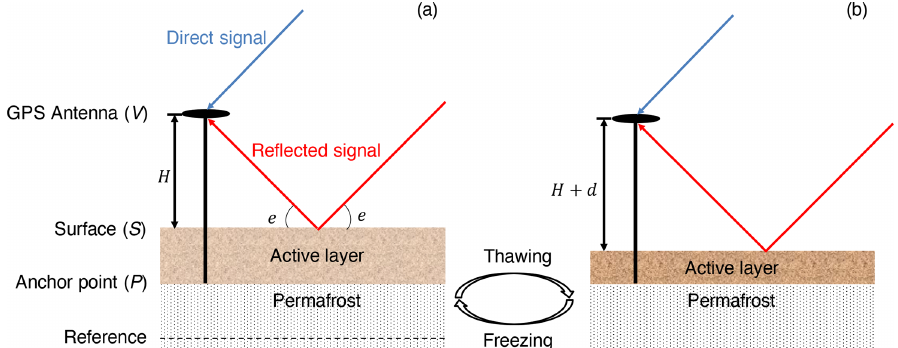
Figure 2. Diagrams showing the geometries of GPS-IR in the thawing/freezing active layer conditions. We use the symbols V , S , and P to denote the vertical positions of the GPS antenna, reflecting surface, and the monument anchor point, respectively, with respect to an arbitrary reference in the deep permafrost marked by a dashed line; H denotes reflector height; d represents surface deformation due to active layer